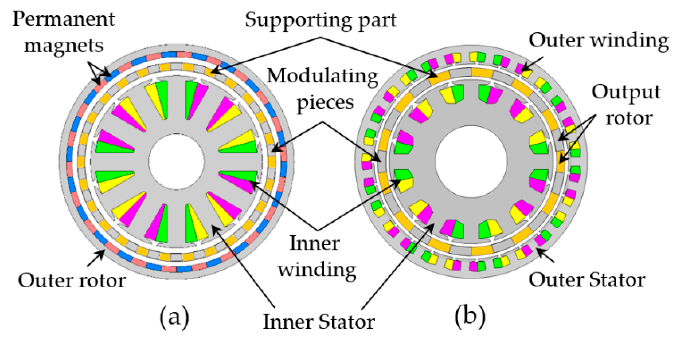
Figure 1. Topologies of the magnetic geared machine. ( a ) PM magnetic geared motor; ( b ) doubly fed magnetic geared motor (DFMGM).